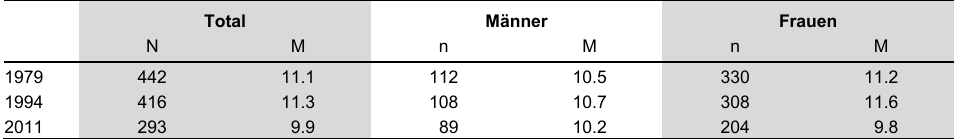
Tabelle 1: Bilanzierung empfundener Schwierigkeiten nach der Verwitwung im Zeitvergleich 1979-2011